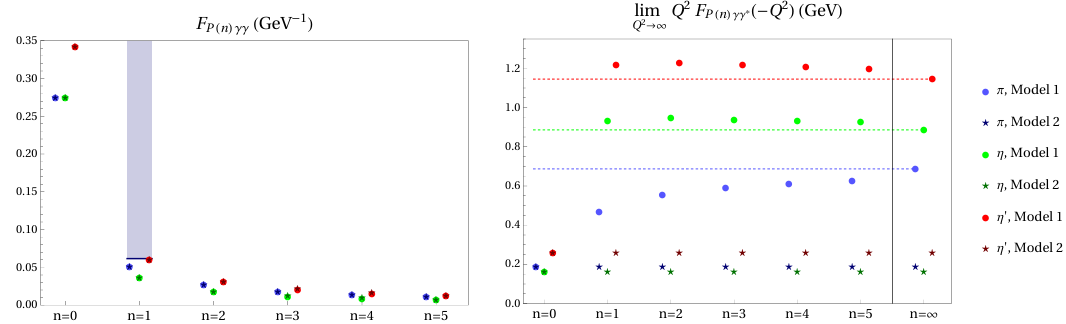
Figure 19. Two-photon couplings and BL limits of the excited-state pion, (cid:17) , and (cid:17) 0 TFFs. The blue, green, and red points (stars) are from the large- N c Regge model (alternative model) for pion, (cid:17) , and (cid:17) 0 , respectively. The blue bar indicates values excluded for F estimate